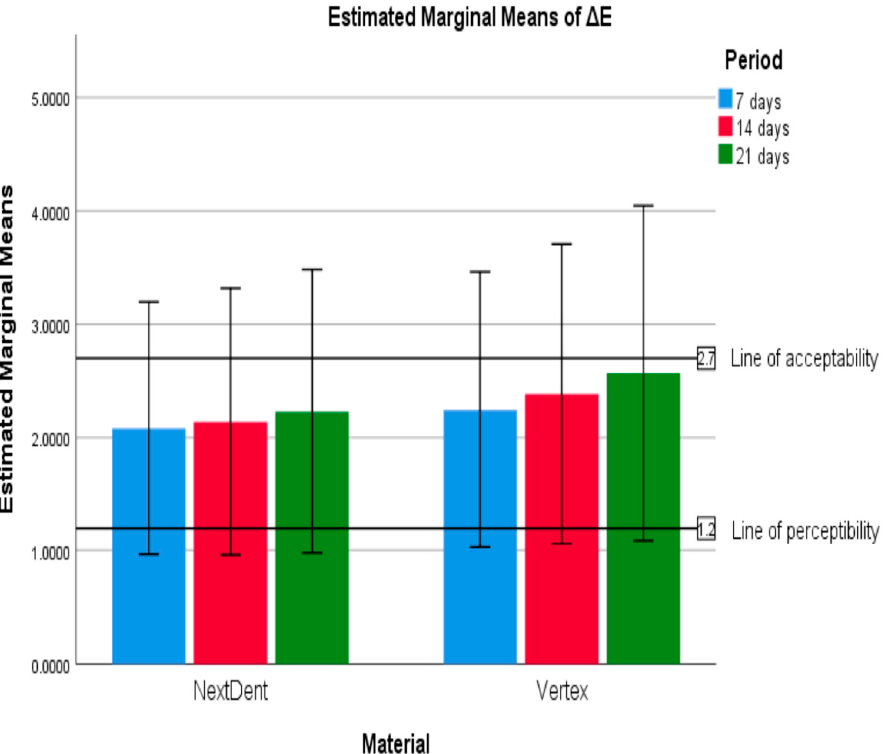
Figure 3. Interactive plot for mean colour difference—interaction between type of material and immersion time, with thresholds of acceptability/perceptibility.